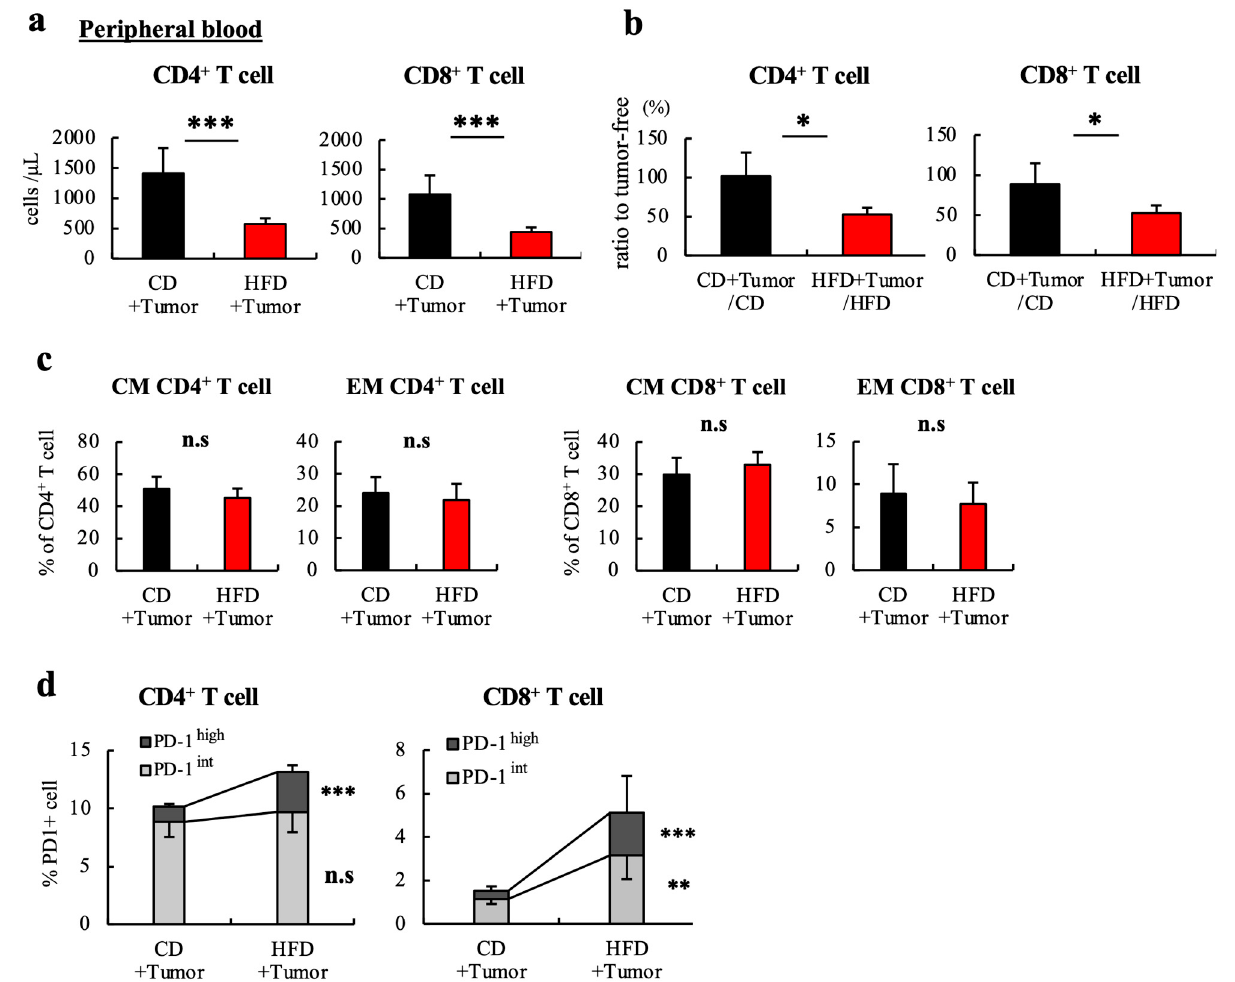
Figure 3. Tumor burden further promotes reduction in the number and exhaustion of CD4+ T cells in the blood of HFD-induced obese mice. ( a ) Three weeks after tumor inoculation, the number of T cells in the peripheral blood of each group were analyzed. ( b ) Ratio of T cell numbers in peripheral blood with tumor-bearing to tumor-free mice in each group are shown. ( c ) The phenotype of peripheral blood T cells of tumor-bearing mice at 12 weeks are shown. The CM and EM of T cells were defined as CD44+ CD62L+ and CD44+ CD62L- cells, respectively. ( d ) The PD-1 expression of peripheral blood T cells of tumor-bearing mice at 12 weeks are shown. PD-1 expression of T cells was analyzed in three groups. The data are expressed as the mean ± S.D. (n = 10 mice in each group). Mann–Whitney’s test was performed for two-group comparisons. * p < 0.05, ** p < 0.01, *** p < 0.005. HFD, High-fat diet; CD, Control diet; CM, central memory; EM, effector memory; PD-1, programmed death-1.